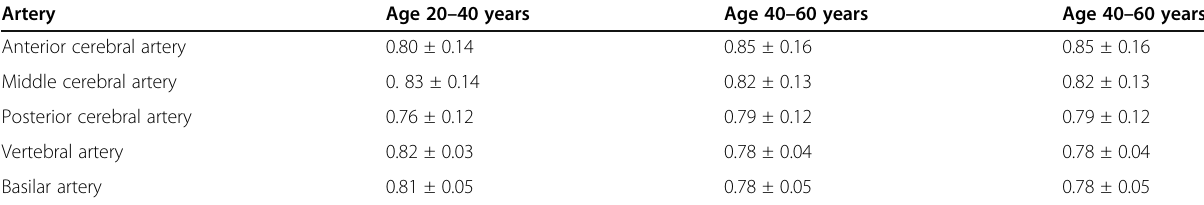
Table 2 Normal pulsatility index (mean ± SD) based on age groups [5]